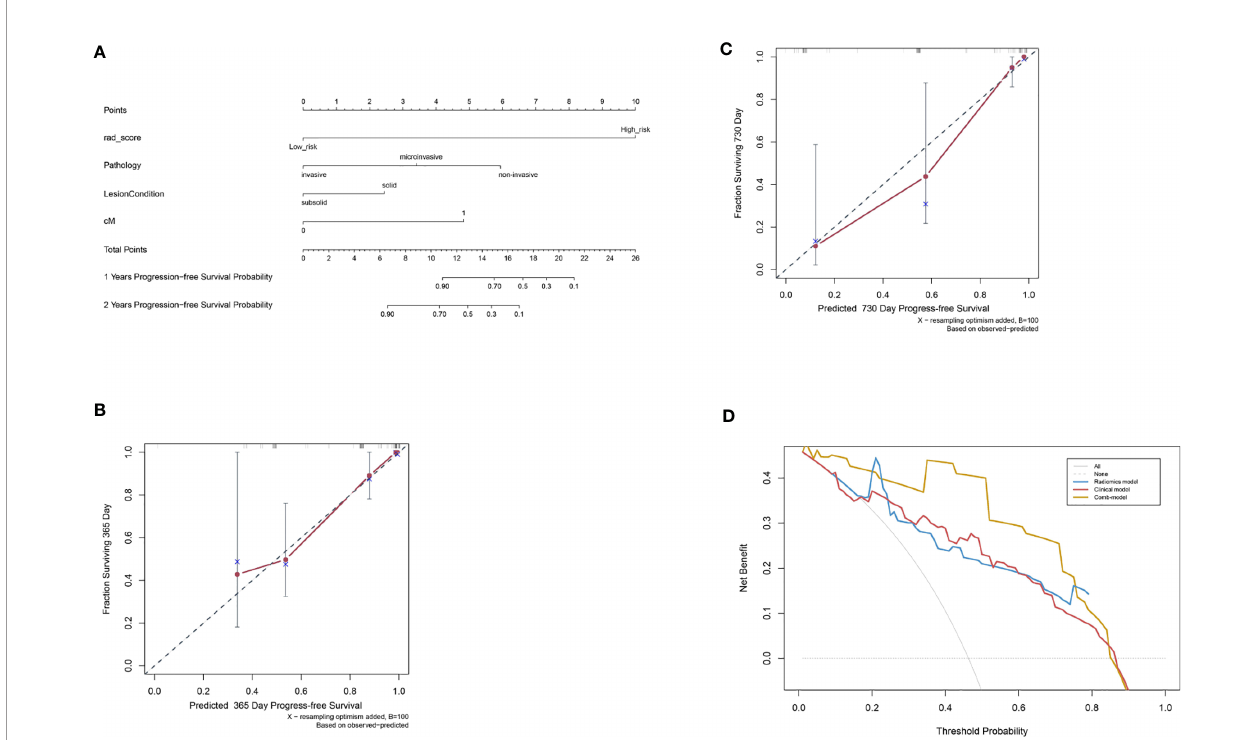
FIGURE 5 | Nomogram to evaluate post-surgical progression-free survival (PFS) of patients with lung adenocarcinoma, and model calibration. (A) A nomogram to predict 1- and 2-year PFS probability. The Rad-score was located on the Rad-score axis, where a line was drawn to indicate the PFS probability point scale. After repeating this process for each variable and accumulating all the probability points, the fi nal PFS probability can be established and indicated on the axis line. (B) Calibration curve for the estimation of 1-year overall survival predicted by the nomogram. The estimated progress-free rate was plotted on the x -axis; the observed progress-free rate was plotted on the y -axis. The Diagonal dotted line = a perfect estimation by an ideal model; solid line = the performance of the nomogram. (C) Calibration curve for the estimation of 2-year overall survival predicted by the nomogram. The estimated progress-free was plotted on x -axis; the observed progress-free rate was plotted on y -axis. (D) Decision curve analysis (DCA) of R-, C-, and Combi-models indicated their clinical net bene fi ts. The blue, red, and yellow lines represented R-, C-, and Combi-models, respectively. DCA showed that the Combi-model gained more clinical net bene fi t than the other two